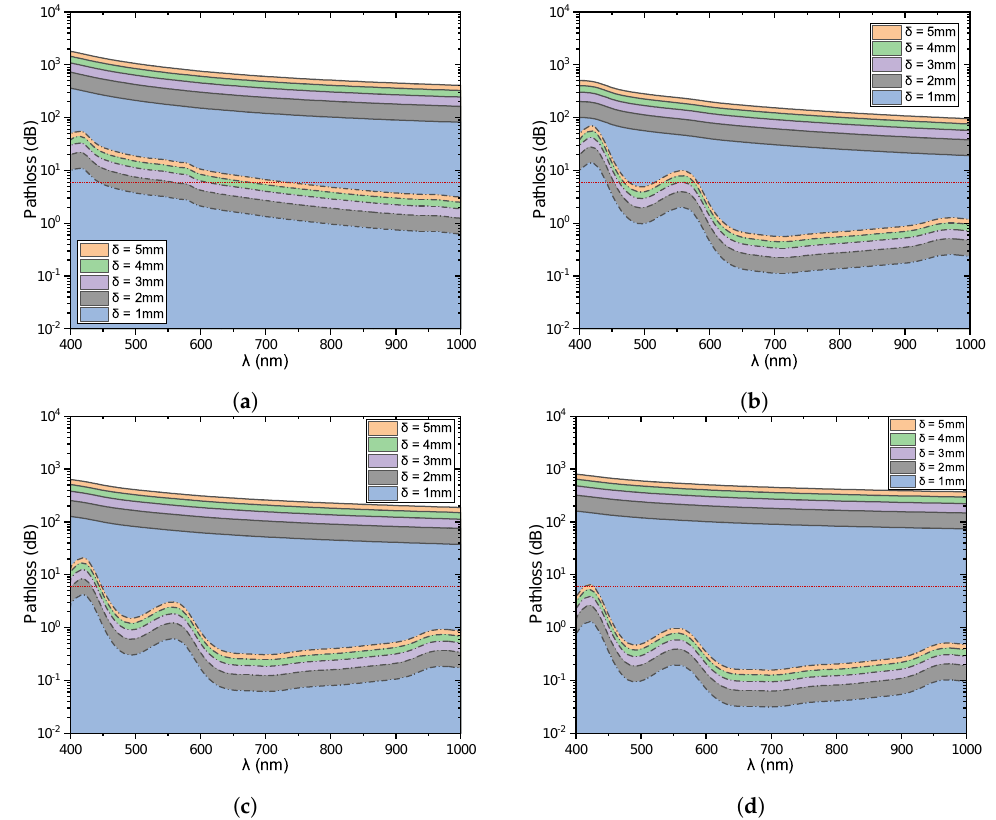
Figure 3. Pathloss due to absorption and scattering of various tissues as a function of the transmission wavelength for different values of tissue thickness. Continuous and dashed lines denote the complete pathloss and the pathloss only due to the absorption coefficient. ( a ) Skin tissue. ( b ) Brain tissue. ( c ) Breast tissue. ( d ) Bone